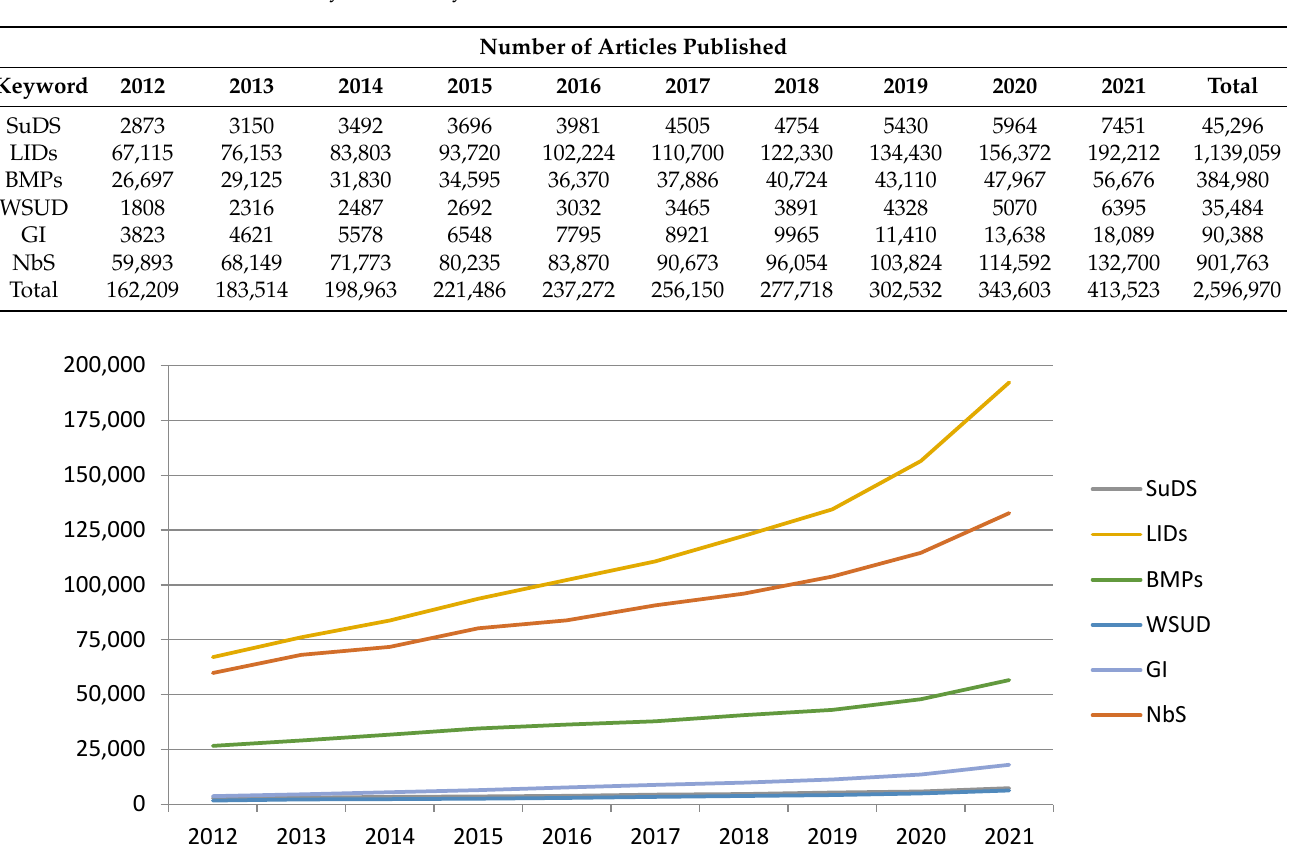
Table 2. Number of scientific articles published on the topic of “soil sealing” according to the